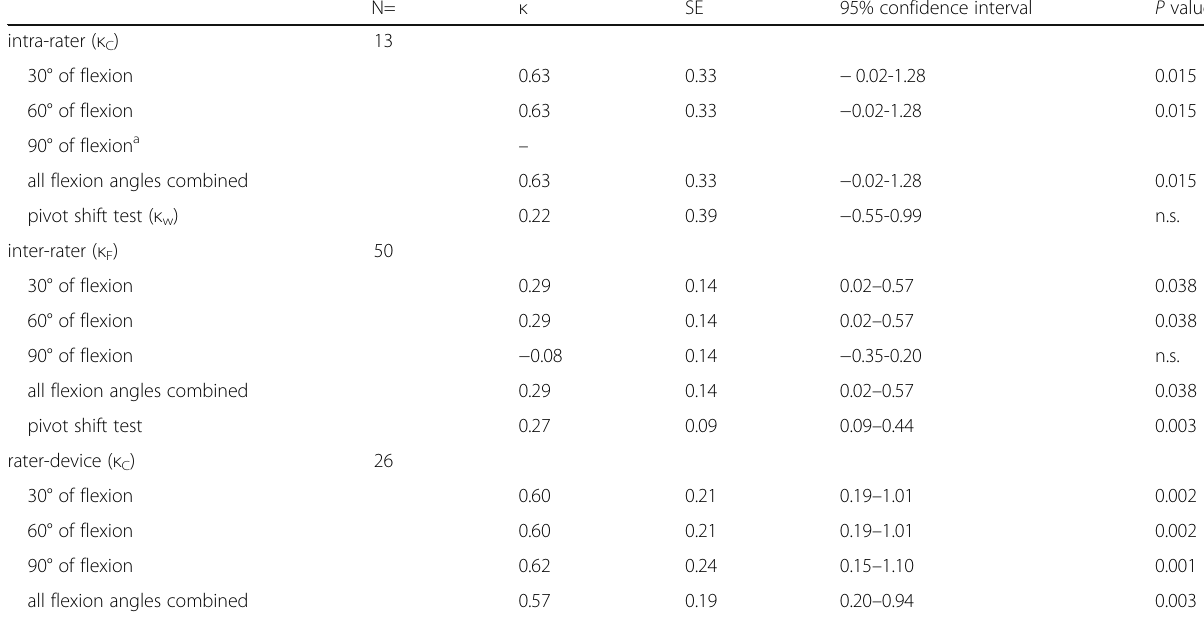
Table 3 Rater-agreement of the TIR test and the pivot shift